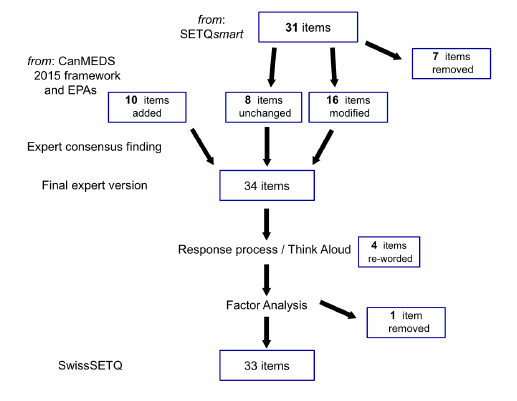
Figure 1: Flow-chart of item handling for the final SwissSETQ in-